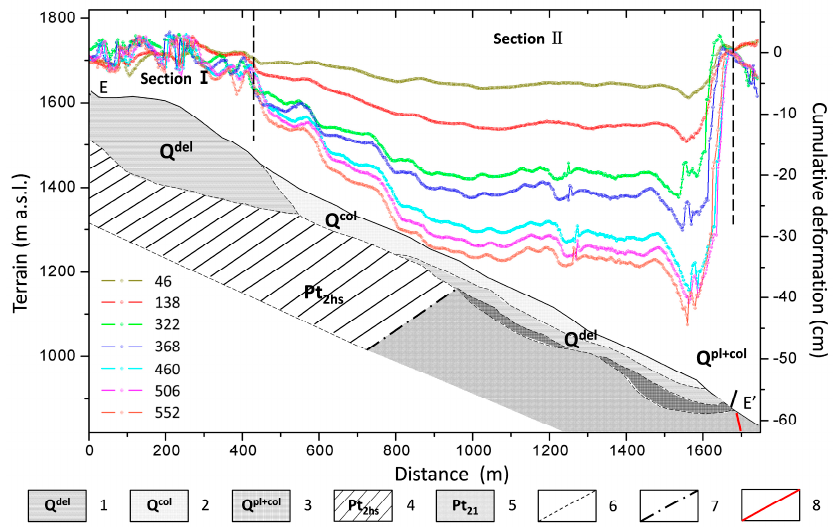
Figure 11. Cumulative InSAR time-series deformation results and geological cross-section map along the profile EE’ (indicated in Figure 8). The reference SAR acquisition date in the third subset is September 1, 2009, and the different cumulative days from the reference date are shown in different colors. 1—Clastic soil of the phyllite; 2—Dolomite gravel with a small amount of silt; 3—Gravel with a small amount of silt; 4—Phyllite; 5—Marble; 6—Stratigraphic boundary; 7—Bedrock boundary; 8—Fault. (Geological cross-section map is modified after Xu [59]).